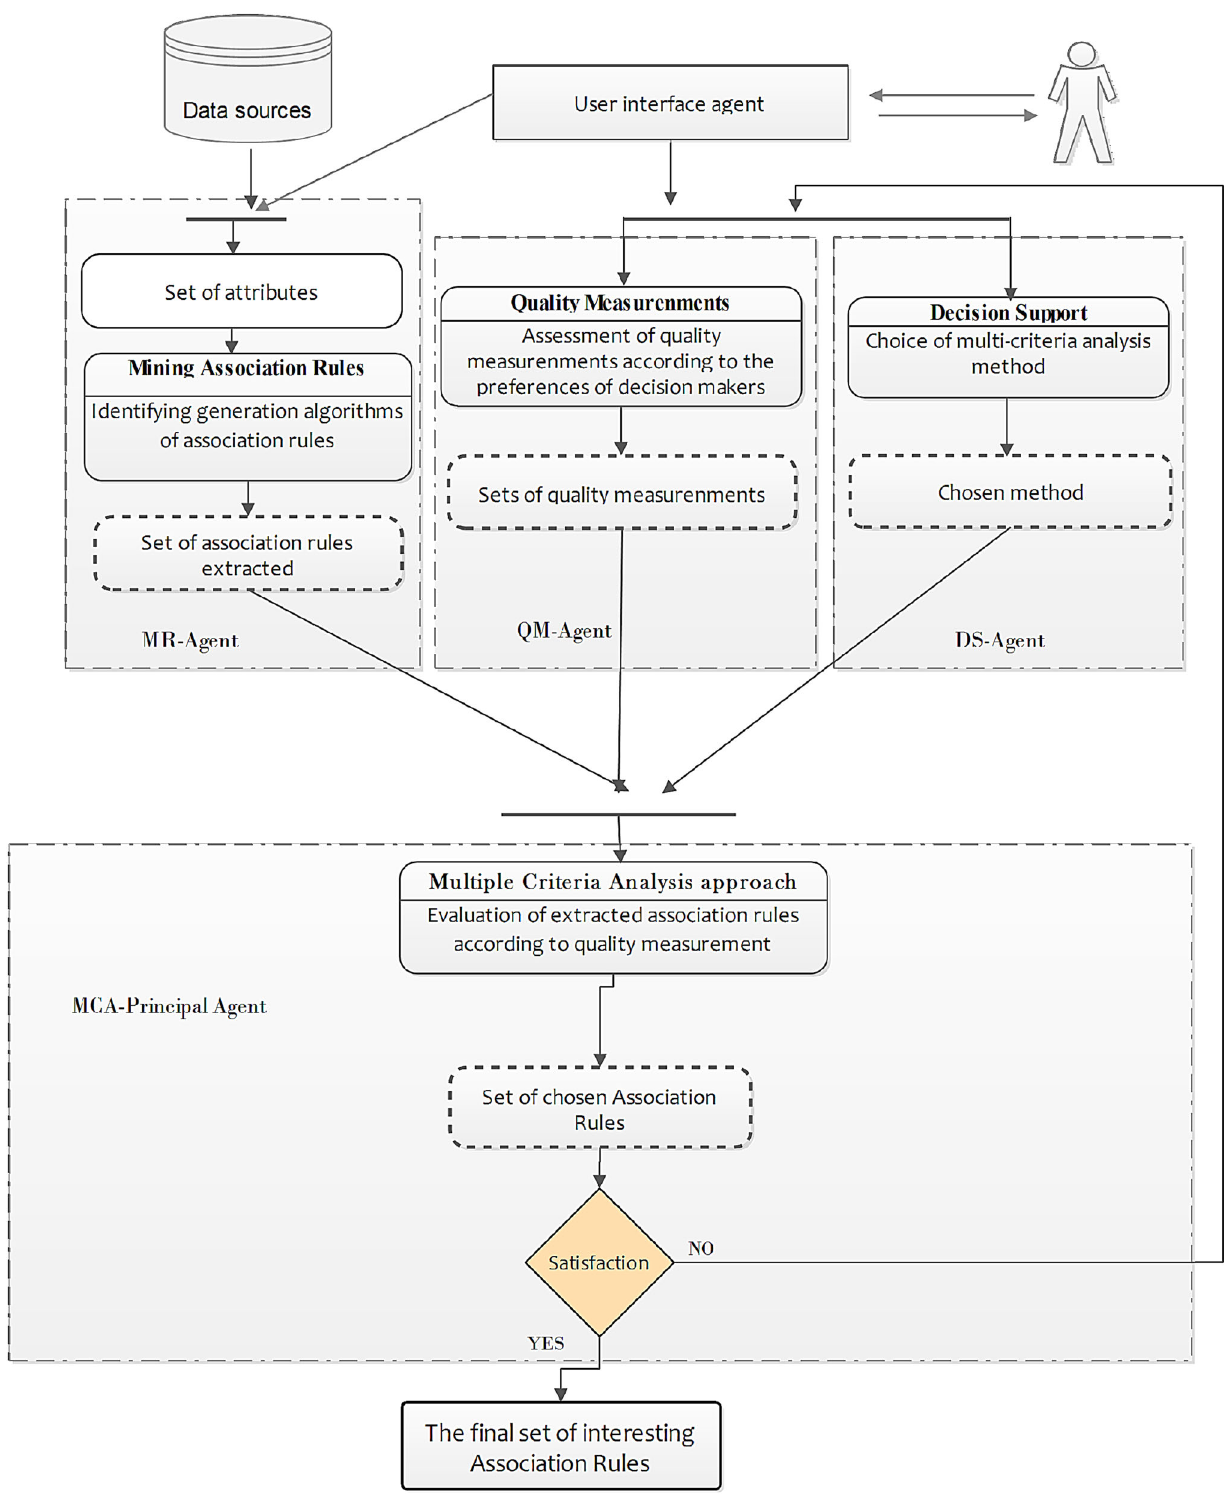
Fig. 4 The proposed multi-agent